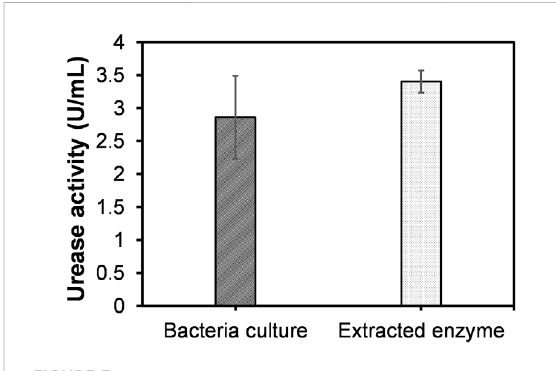
FIGURE 3 Comparison ofactivitiesbetweenwhole-cell bacteriaculture and extracted enzyme.